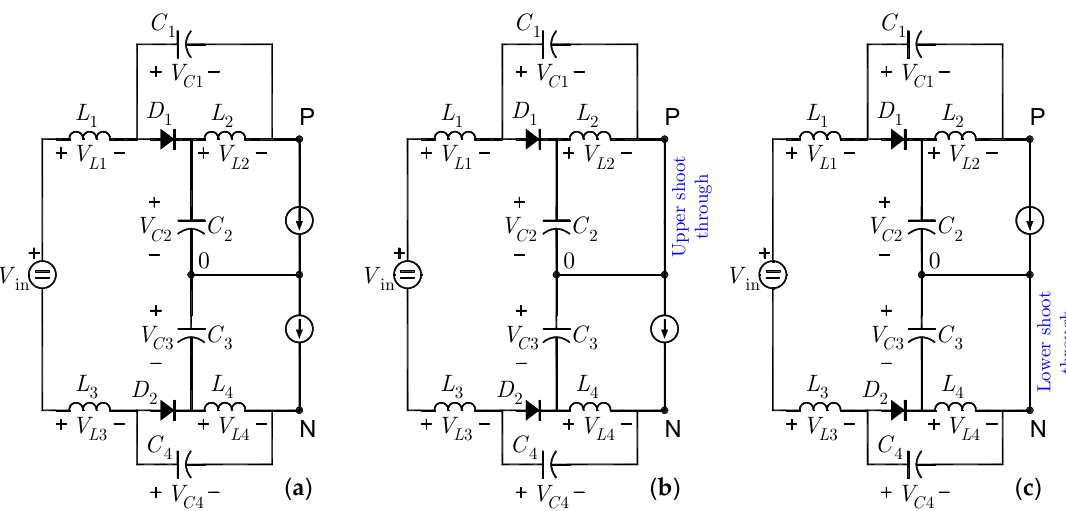
Figure 3. Equivalent circuits for ( a ) non-shoot-through (NST) state, ( b ) upper shoot-through (UST) state, and ( c ) lower shoot-through (LST) state.